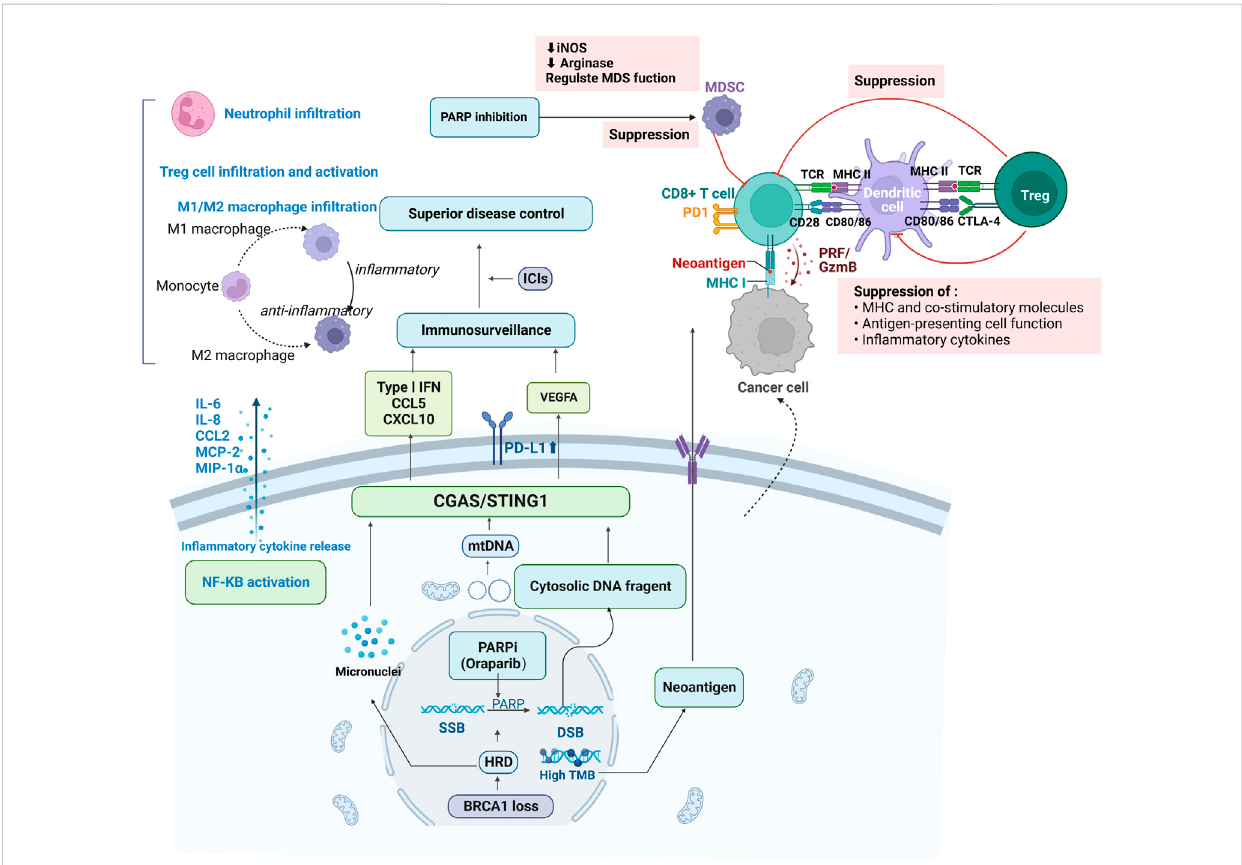
FIGURE 4 Synergy of immune checkpoint inhibitors with PARPi and tumor suppressive immune microenvironment. PARPis induces double-strand breaks in HRD cells, generating cytoplasmic dsDNA fragments, micronuclei and mtDNA, which trigger the activation of the STING pathway by binding to cyclic GMP-AMP synthase(cGAS); ontheone hand, itupregulatesthesecretion oftypeIinterferon,CCL5,CXCL10 and VEGFA,promoting immune escape. On the other hand, low levels of DNA damage stimulate in fi ltration of suppressive immune cells, such as myeloid-derived suppressor cells (MDSC) or tumor-associated macrophage (TAM), which leads to the release of free radicals and triggers further DNA damage. Antigen-presenting cells, including tumor-associated dendritic cells, are recruited and activated to drive STING-dependent type I IFN signaling. Increased expression of T cell-associated chemokines activates CD4 + and CD8 + T lymphocytes in tumor and bone marrow-derived cells, increasing in fi ltration of cytotoxic T-cell in the microenvironmentand promotingreprogramming ofimmune cellstophenotypeswithantitumoractivity.PARPisalso activatesPD-L1 transcription,PD- 1/PD-L1 blockade and enhances antitumor immunity; activation of the κ B pathway and release of various cytokines inhibit epithelial-mesenchymal transition (EMT), thereby increasing immune cell in fi ltration at tumor